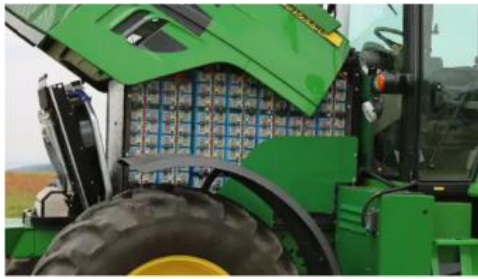
Fig. 23. Battery pack of John Deere SESAM [36]